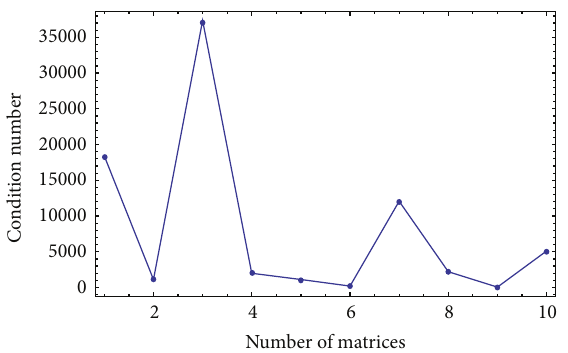
Figure 1: Comparison of condition numbers for the 10 test sparse matrices in Experiment 1.